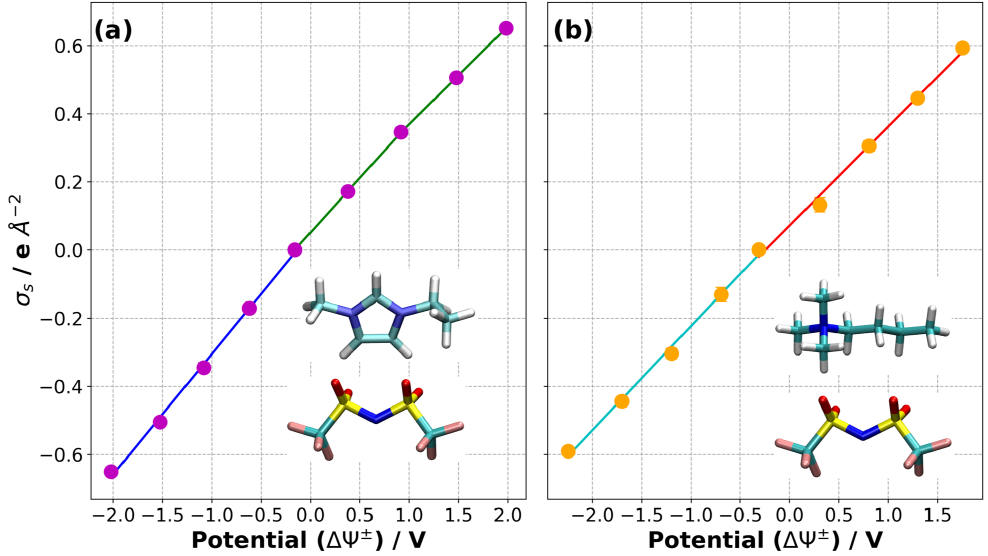
Figure 12. Surface charge density versus potential ( ∆Ψ + / − ) plots for the calculation of differential capacitance for (a) [C 2 mim][NTf 2 ] and (b) [N 4,1,1,1 ][NTf 2 ] system. Lines with different colours correspond to a slope used to calculate differential